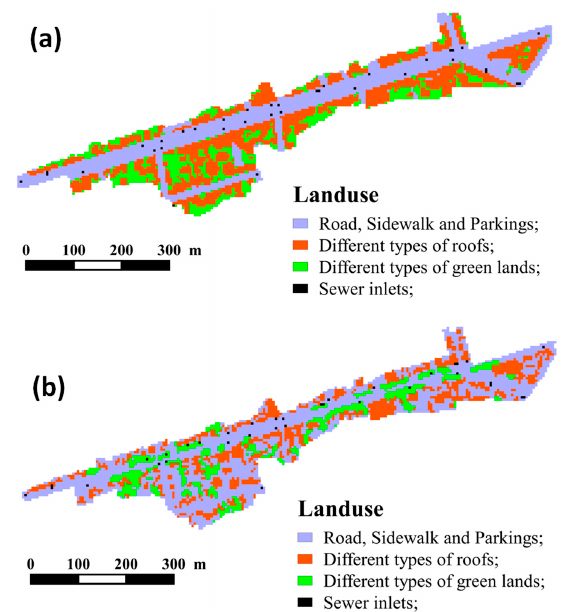
Figure 6. Land use (LU) input map (5 m) converted from different data sources: ( a ) from the detailed LU information which is derived from ortho photos; ( b ) from the coarser LU information which is used for urban